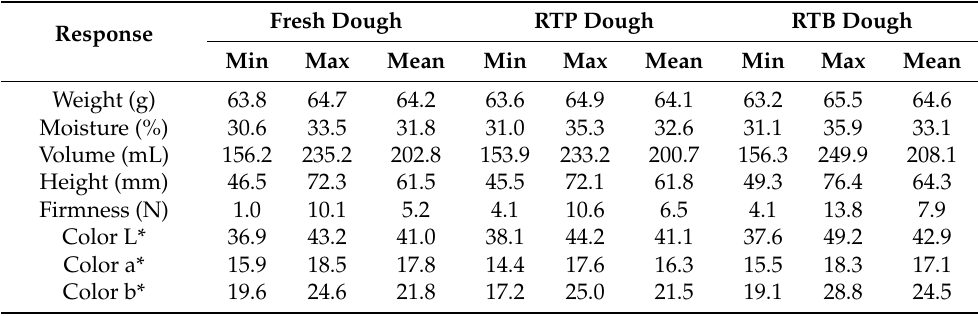
Table 2. Minimum (Min), maximum (Max), and mean values measured quality characteristics of bread made with fresh dough and with the RTP and RTB frozen